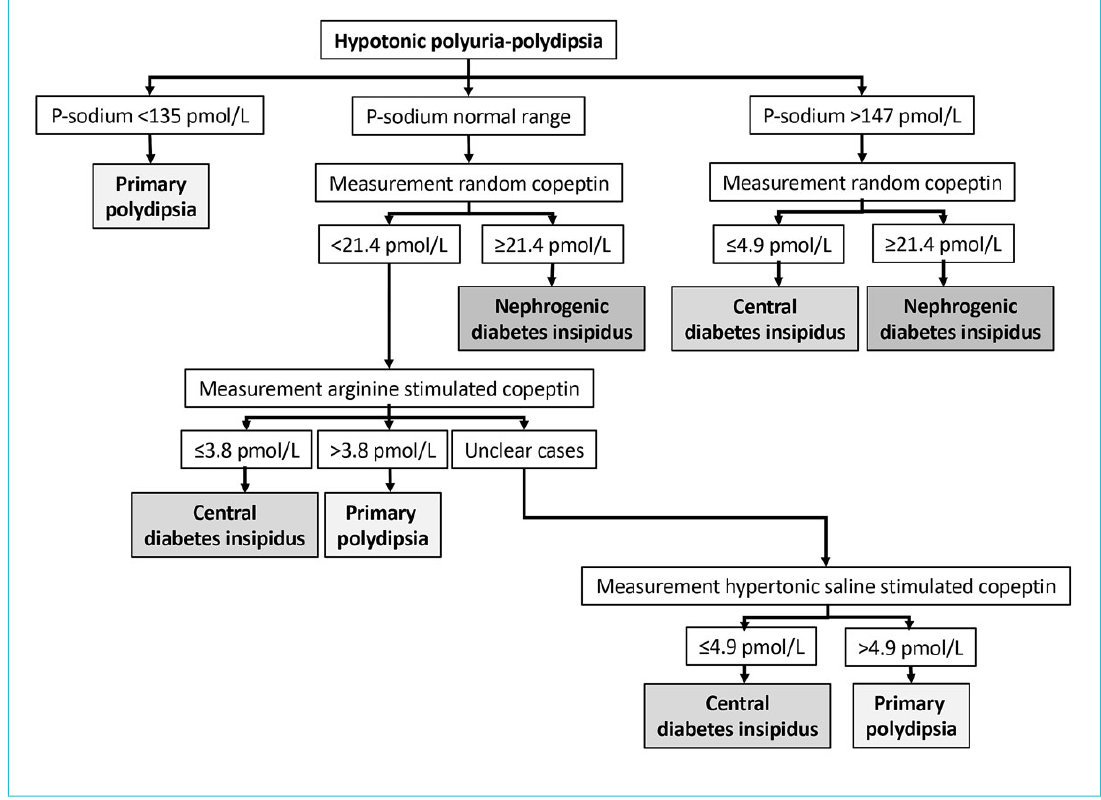
Figure 4: Copeptin-based diagnostic workflow for the differential diagnosis of polyuria-polydipsia syndrome. Unclear cases with the arginine stimulation test: in patients with severe nausea or vomiting test results have to be interpreted with care. Hypertonic saline stimulated copeptin: measurement copeptin level at sodium >147−150 mmol/l. P =